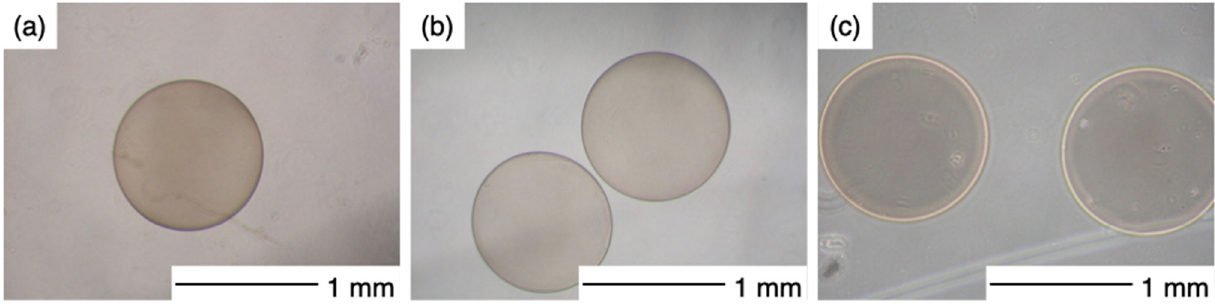
4 of 10 Figure 1. Photographs of the injection system. ( a ) The injection equipment; ( b ) injection into the ChG2 capsule using a glass micropipette. 2.5. Drug Release After loading the cytochrome C, the capsules were incubated in acidic saline solution